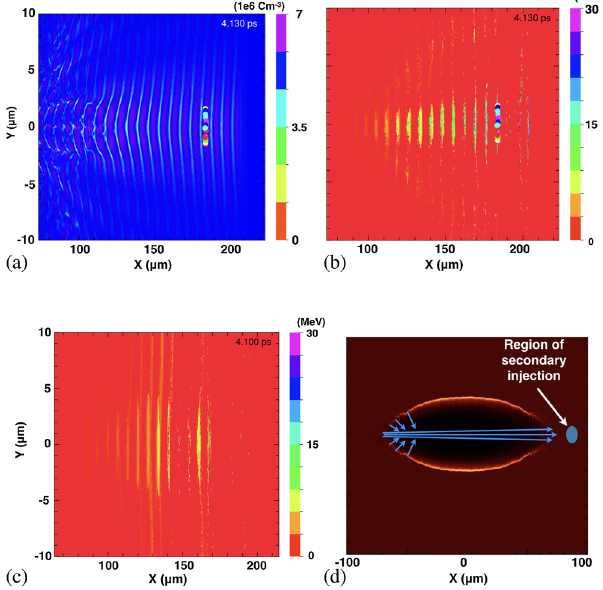
FIG. 4. (a) Lineouts along y ¼ 0 , just before trapping occurs: massdensity (black), electric fieldin X (blue), electric fieldgradient in X (red), the markers show the positions of the tracer particles, for these, the Yaxis isposition. (b) The samegraph as (a) but at the time when the wake enters the blast-wave, and trapping occurs. The density drop induces a sharp peak in the electric field gradient, which traps the particles. (c) The mass density at the time of injection, markers show the tracer positions. (d) Charge density showing the wake structures and tracer positions.